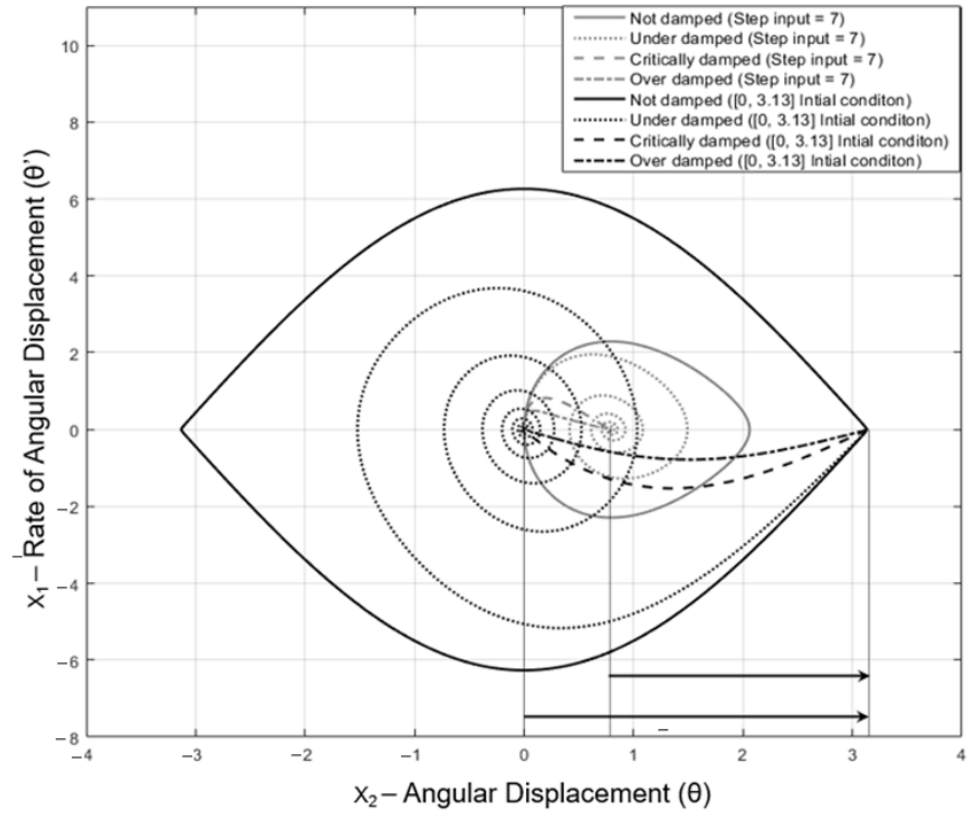
Figure 17. Permanent input (step input) acting as a parameter (input perturbation) that moves the system equilibrium state and affects resilience (Case example 2).